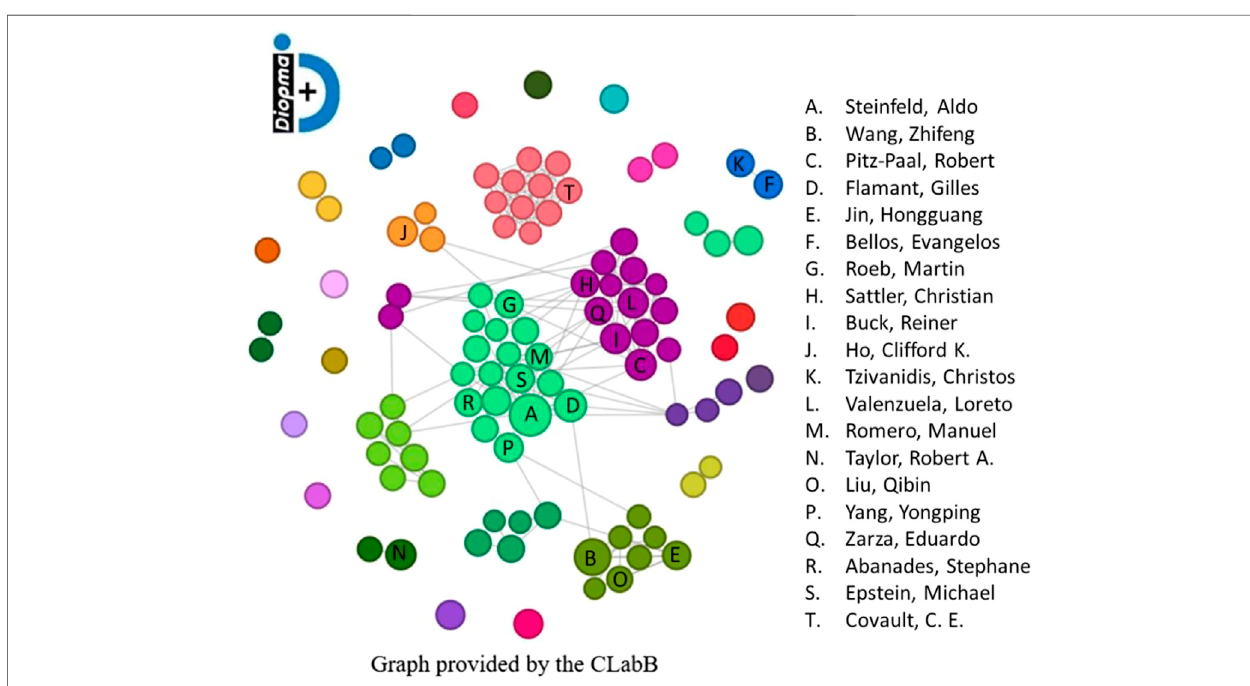
FIGURE 7 | Authorship communities based on the interaction of published papers in CSP fi eld (Calderón, 2019).